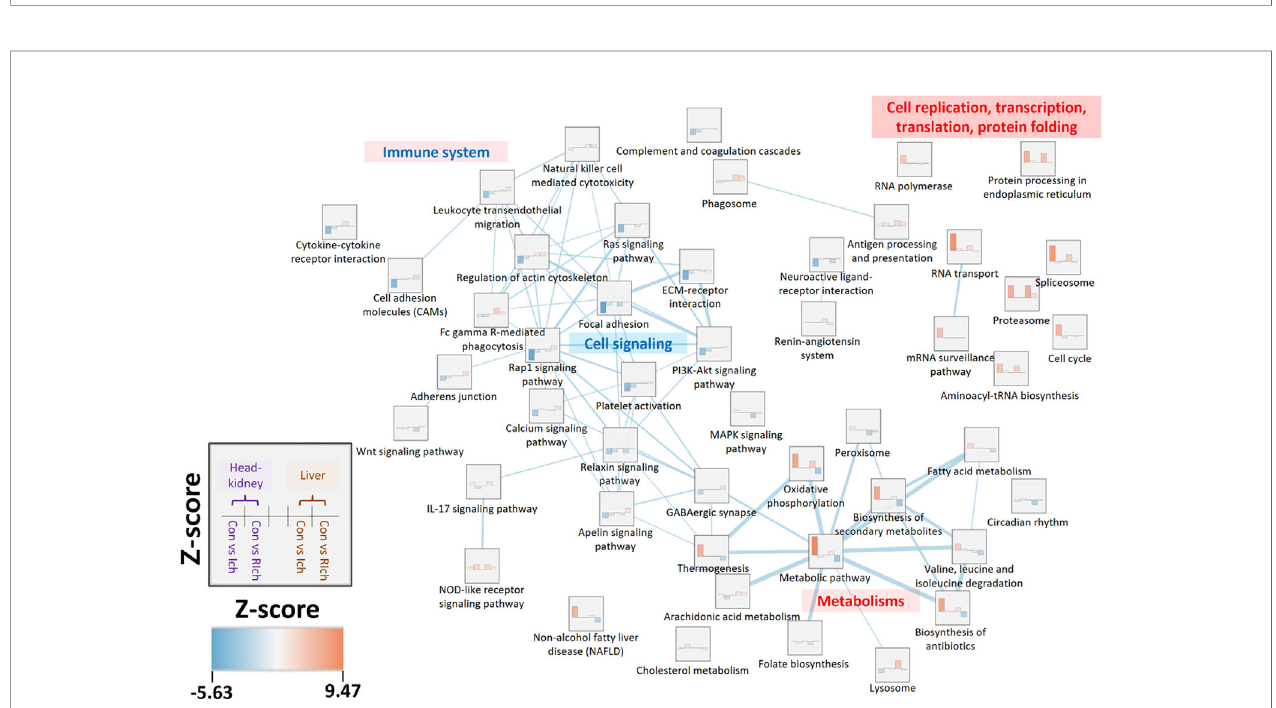
FIGURE 4 | Enrichment network analysis based on top 10% co-expressed pathways in the head kidney and liver during I. multi fi liis infection and recovery. Z-scores range from blue (lower Z-score) to red (higher Z-score). Edges and edge thickness, which represent biological similarity and the degree of overlap between two pathways, are shown in the light blue line. More detailed information is available in Tables S6, S7